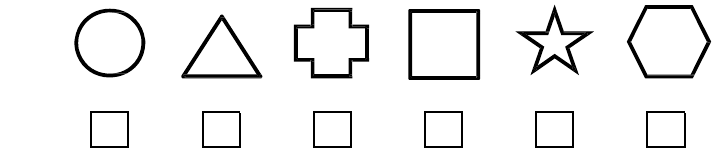
Figure A1. Feedback/decision sheet in the Observation